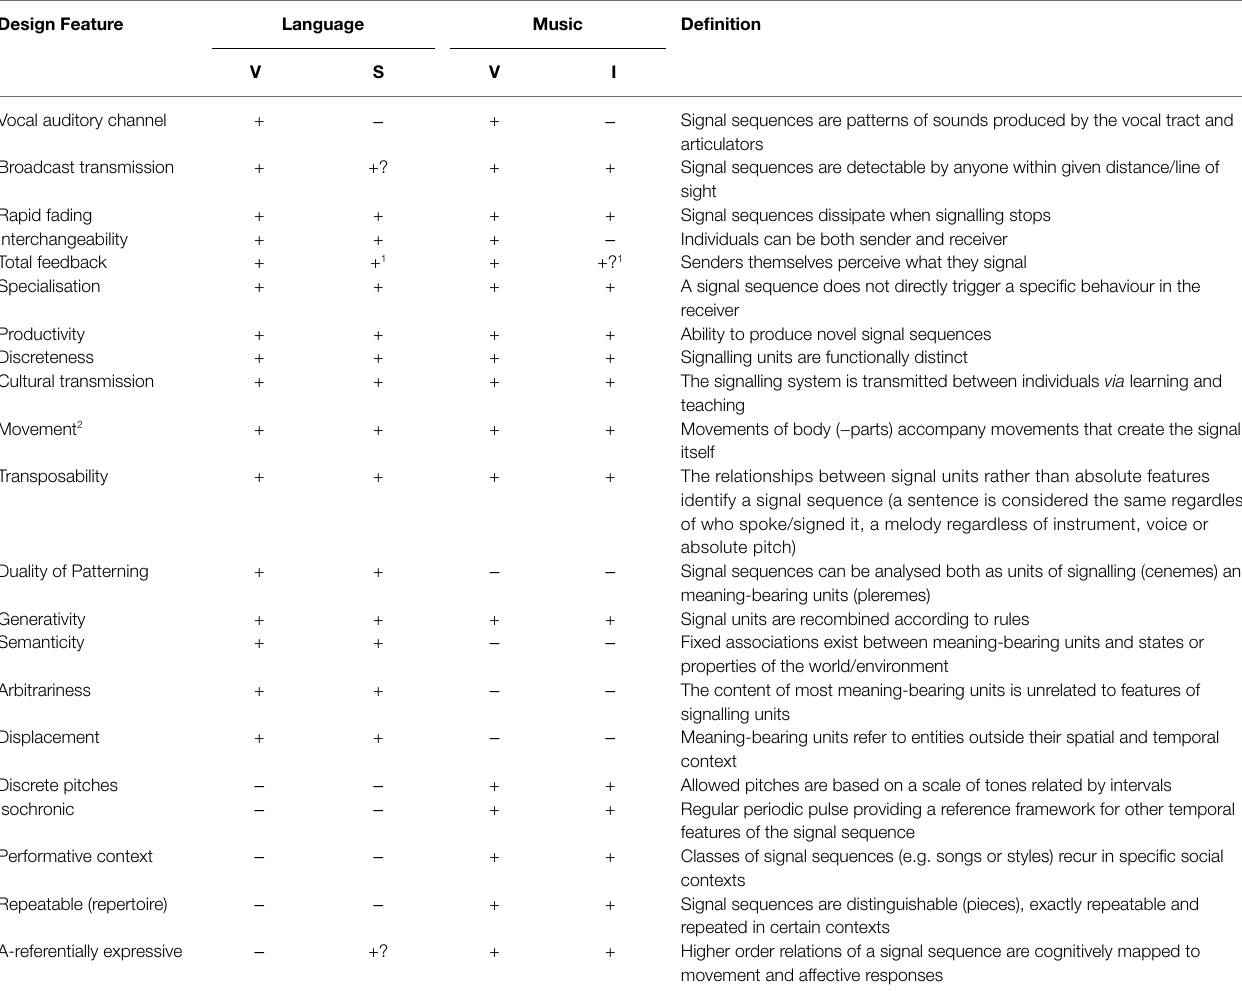
TABLE 1 | Design features differing between language and music, updated from Fitch (2006).